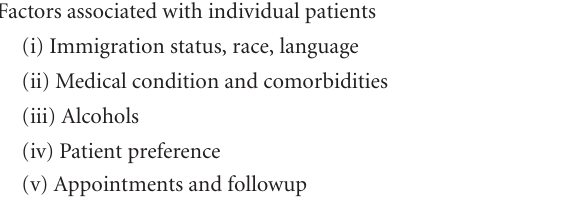
Table 1: Factors influencing the e ffi cacy of treatment of hepatitis C